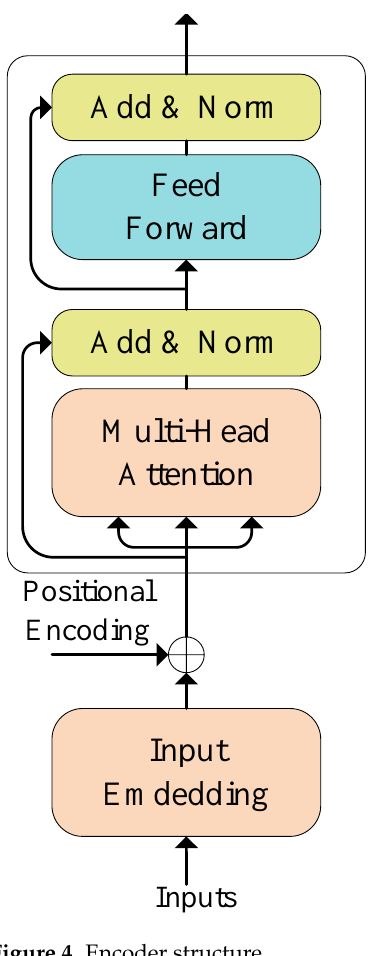
Figure 4. Encoder